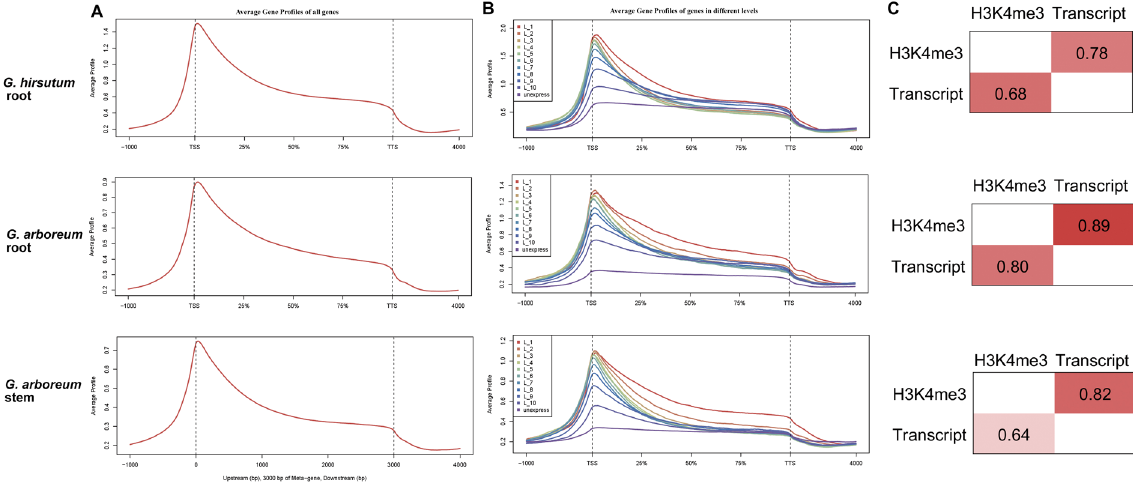
Figure 3. H3K4me3 associated with gene structure and expression. ( A ) The average gene profiles of H3K4me3 in cotton root and stem were generated from CEAS software using normalized sequencing read density. The gene body was divided into three equal parts to standardize different gene lengths, and the 1 kb upstream and downstream regions were also included for profile making. ( B ) The average gene profiles of H3K4me3 among different expression levels. Genes are divided into 11 groups according to their expression (FPKM value). The genes having FPKM > 0 are divided into 10 equal parts and the remaining genes which have FPKM = 0 are gathered and tagged as “unexpressed”. L1 is the highest-level group and is marked in red. L10 is the lowest level and is marked in dark blue. ( C ) The relationship between histone modification and active transcript expression. The numbers are standard for concurrence frequency computation for H3K4me3 histone modifications and active transcripts. For example, 0.78 means that 78% active transcripts contain the H3K4me3 modification in G. hirsutum